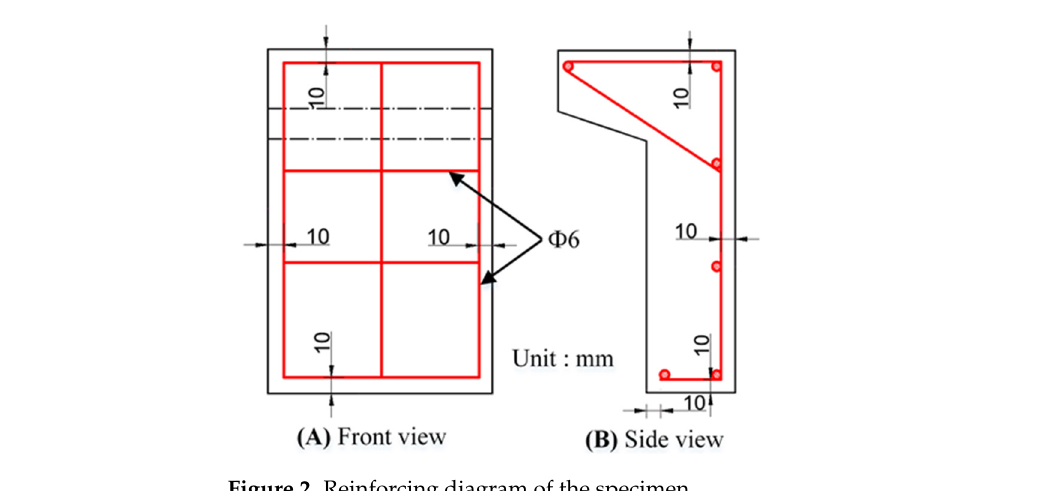
Figure 2. Reinforcing diagram of the specimen. Table 1. Specimen